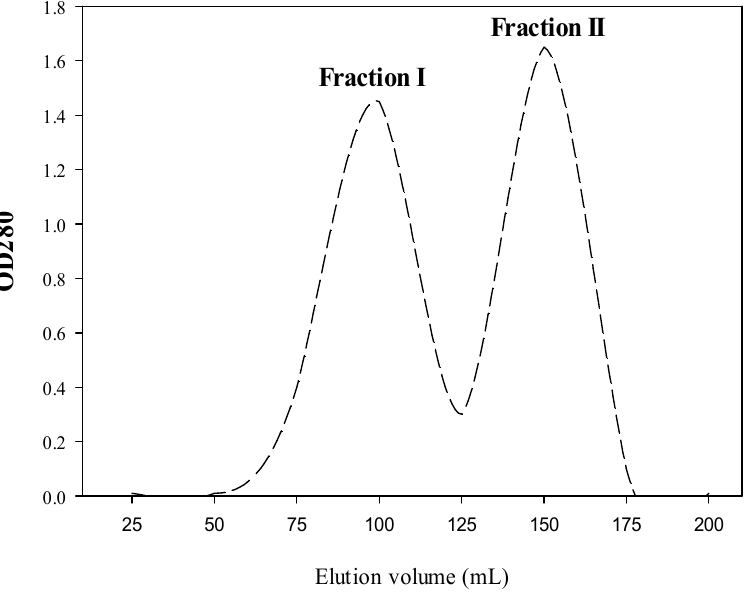
Figure 2. Size exclusion chromatography (SEC) using Sephadex G-25 of the 4 h cowpea seed protein hydrolysate (CPH) obtained by treatment with Alcalase.